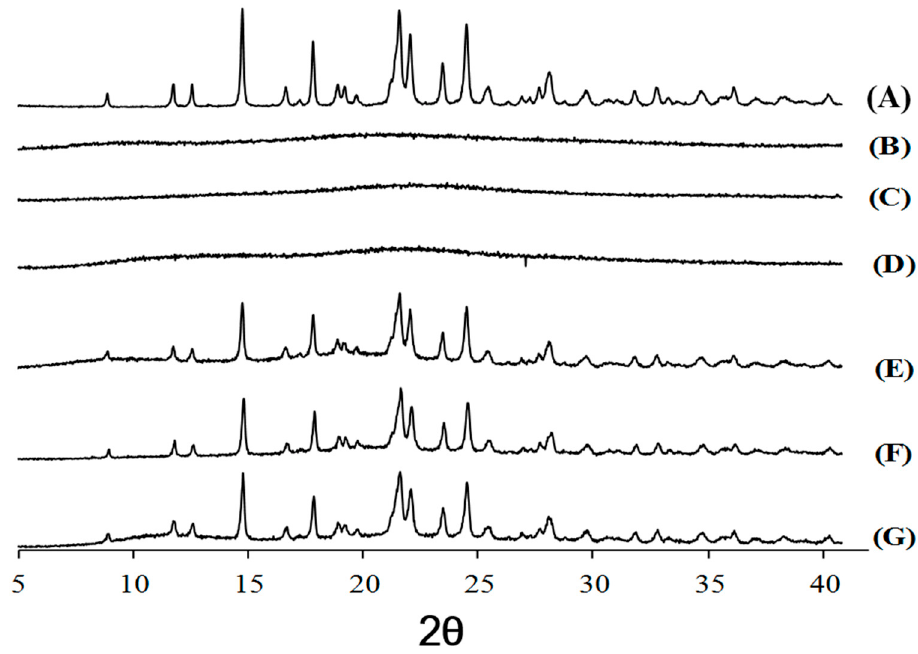
Figure 5. The p-XRD patterns of cefdinir ( A ), CSD1 ( B ), CSD2 ( C ), CSD3 ( D ), physical mixture of cefdinir and HPMC ( E ), physical mixture of cefdinir and CMC-Na ( F ), and physical mixture of cefdinir and PVP K30 ( G ).